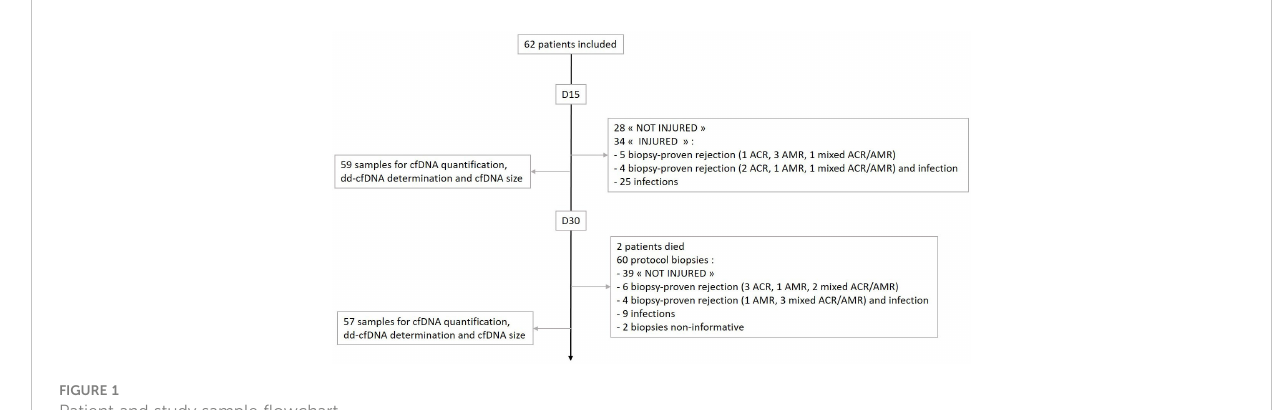
TABLE 2 Description of injured graft patients at D30. Table 2A Description of injured graft patients at D30: Biological characteristics of Acute Rejection.